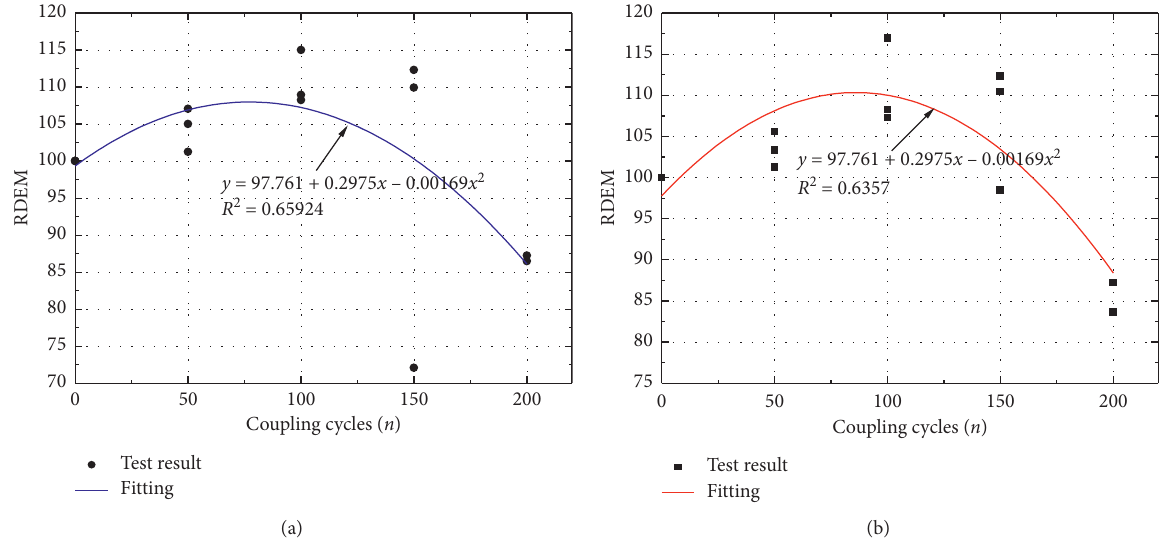
Figure 4: The relationship between RDEM and coupling cycles.